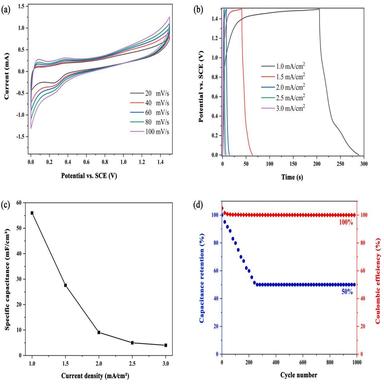
Electrochemical performance of CdSe (40 min) symmetric aqueous supercapacitor (a) CV curves at different scan rates with 1.5 V, (b) GCD curves at different current densities with 1.5 V, (c) specific capacitance line diagrams, and (d) cycling stability and coulombic efficiency of 1000 cycles at the current density of 2 mA/cm2 .